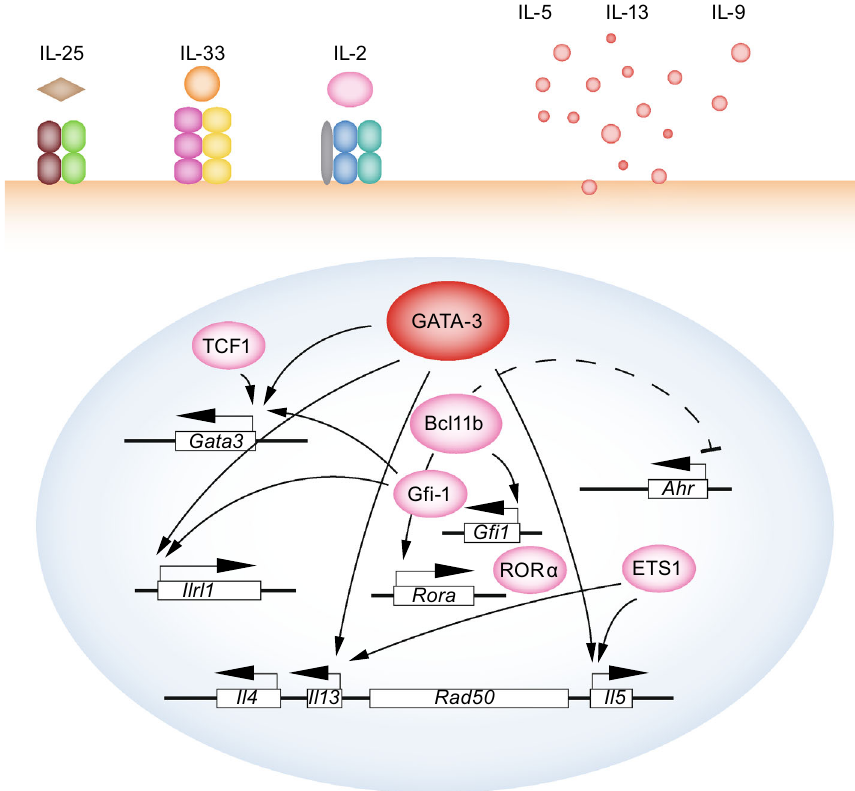
Figure 2. ILC2-speci fi c transcription factors. GATA-3, which determines ILC2 development, maintenance and effector cytokines IL-5 and IL-13 production, is the master regulator of ILC2s. ROR α , Bcl11b, ETS1, TCF1, and G fi -1 are involved either in ILC2 development at early stages or in functional regulation of ILC2s after maturation. TCF1 regulates Gata3 expression at a very early stage to regulate ILC2 development. ROR α and Bcl11b are also speci fi cally required for the development of ILC2 cells. Mature ILC2s express IL-17RB, T1/ST2, and CD25 on their surface, and are responsive to stimulation by IL-25, IL-33, and/or IL-2. After fate and Rora expression, and negative regulation of Ahr expression. G fi -1 directly binds to the Il1rl1 locus to regulate IL-33